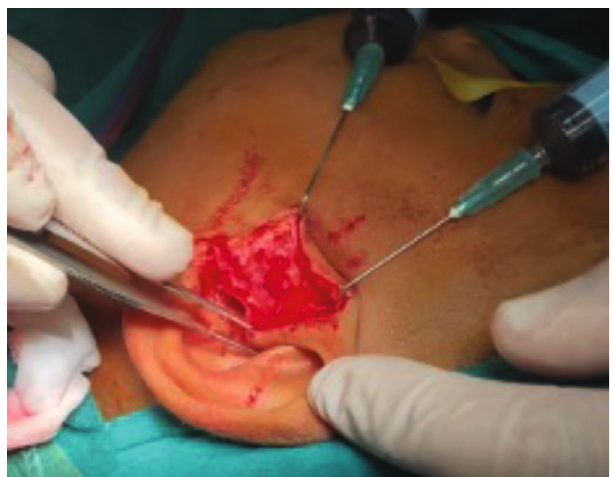
Figure 5: Endaural approach to access the ankylotic mass.